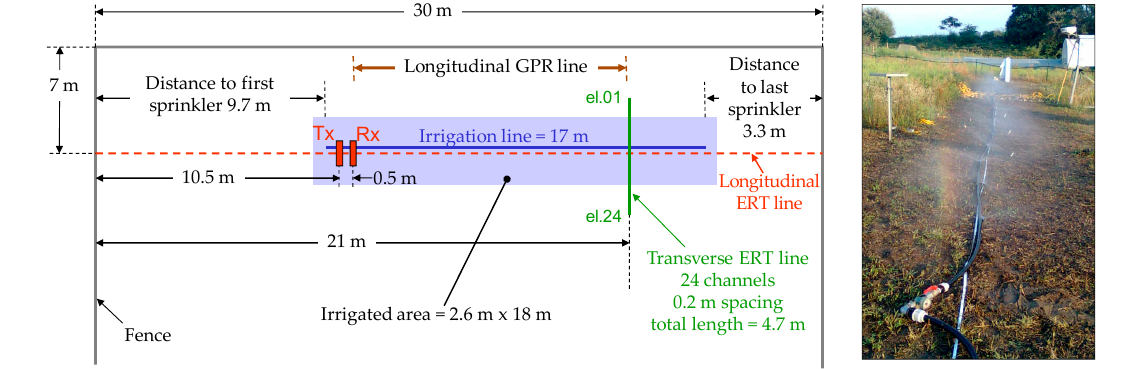
Figure 3. Grugliasco site, August 2009. Scheme of the irrigation experiment setup and a picture taken during the experiment.